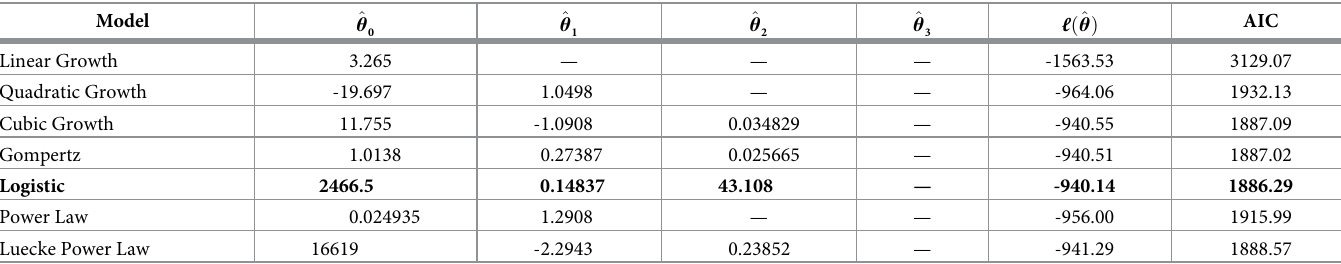
Table 24. Fetal right ventricle blood flow models (mL/min vs. fetal mass in g for power law models, mL/min vs. gestational age in weeks for all other